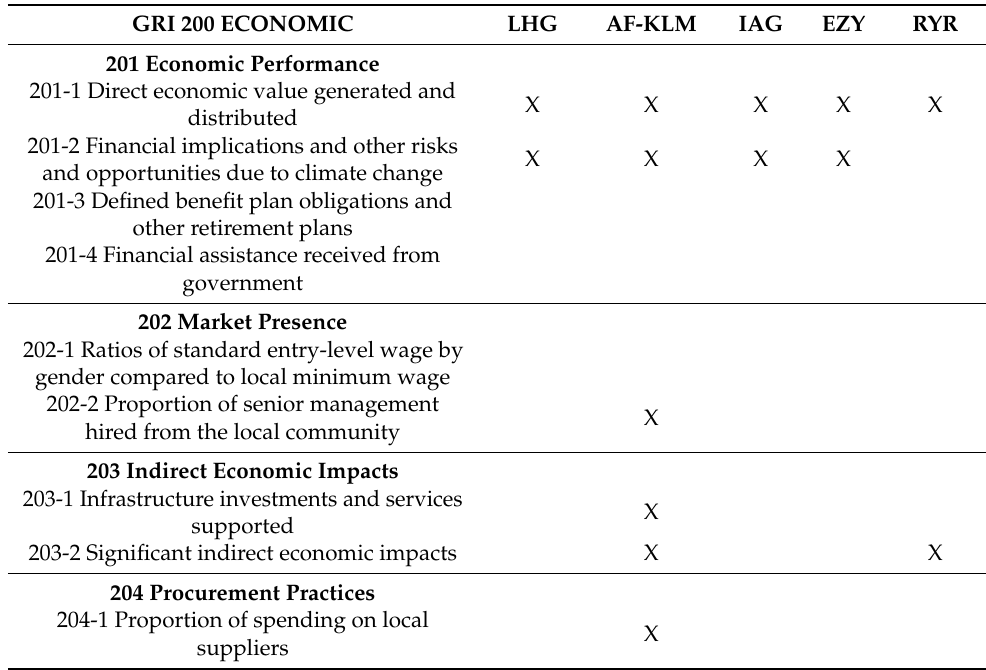
Table 3. Reported disclosures within GRI 200